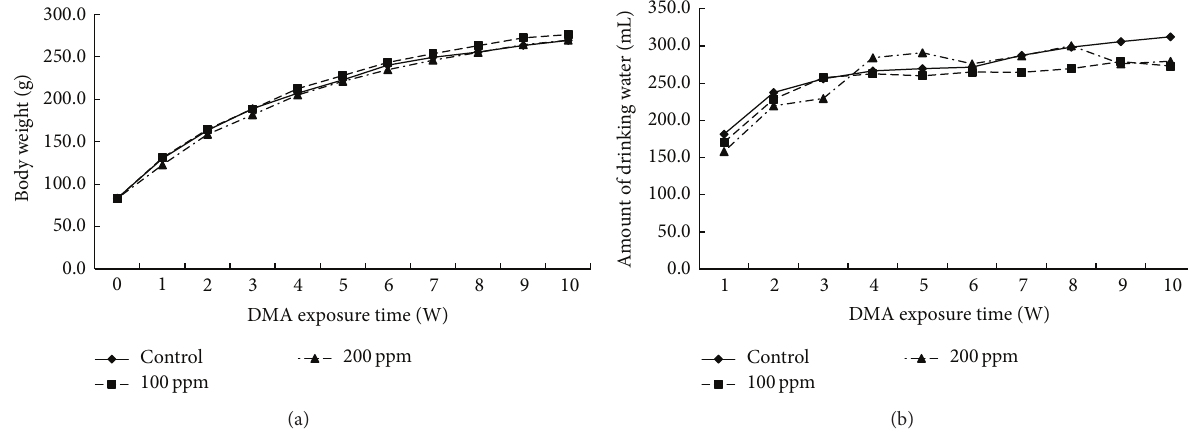
Figure 1: Body weight and real amount of drinking water of rats. The linear charts represent (a) body weight (g) and (b) amount of drinking water (mL) of rats after being exposed to 100 or 200 ppm DMA V in drinking water from the first week to tenth